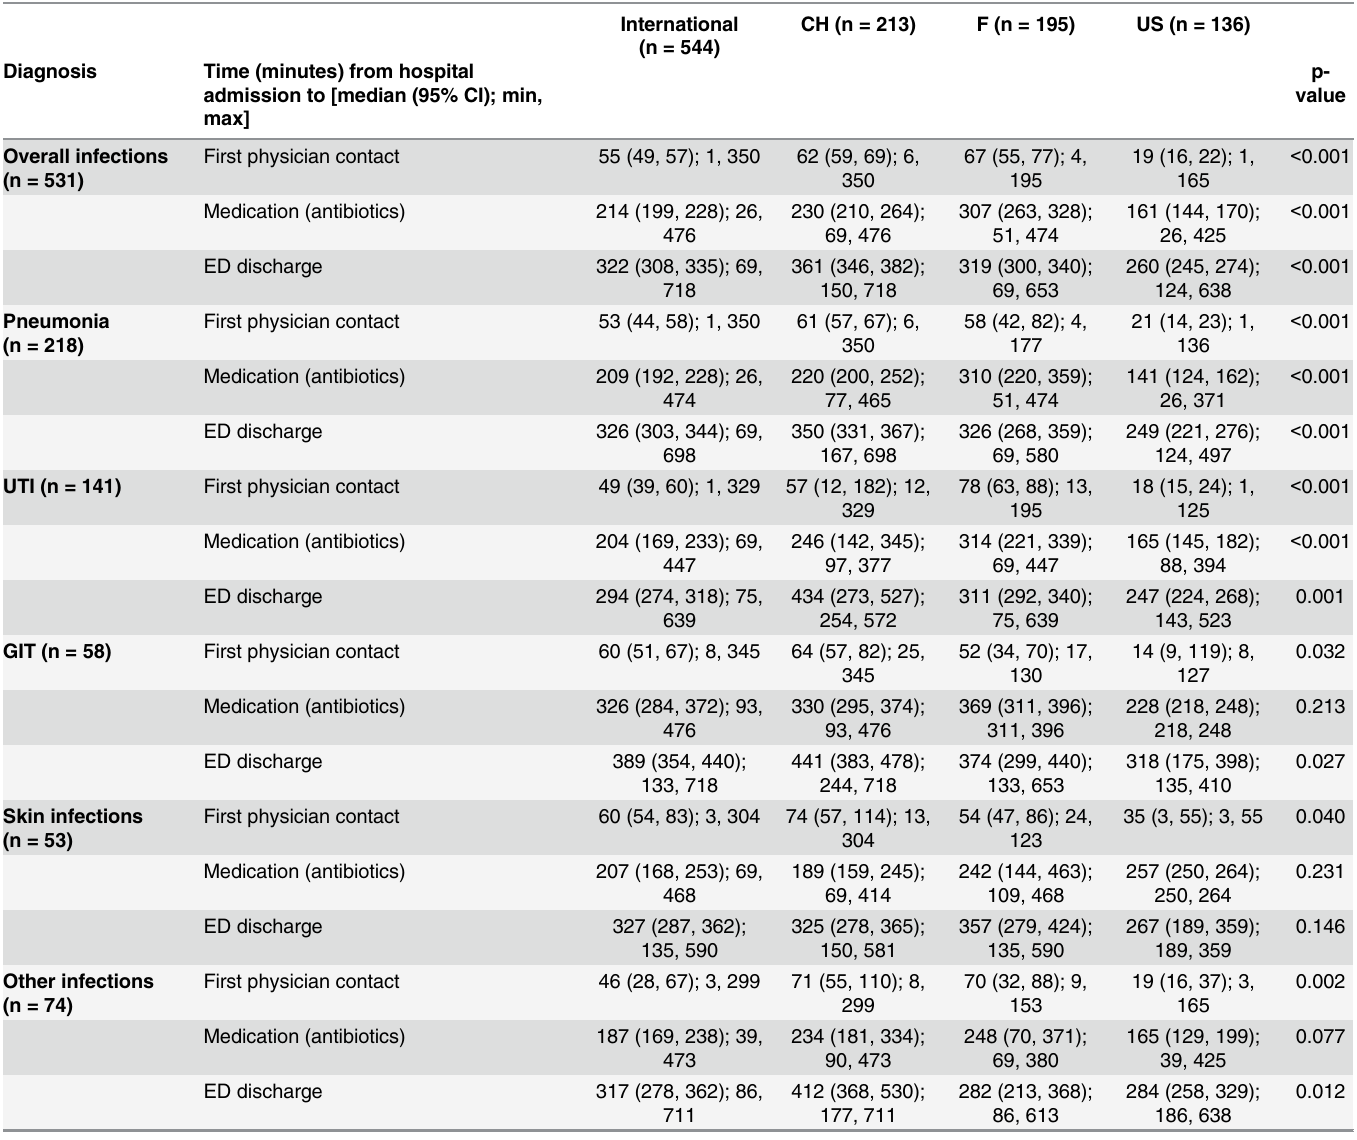
Table 2. Timeliness of ED